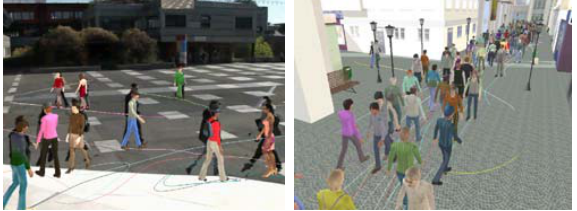
Figure 7. (left) reconstructed trajectories viewed from one of the video cameras, (right) synthesized crowd reusing trajectory